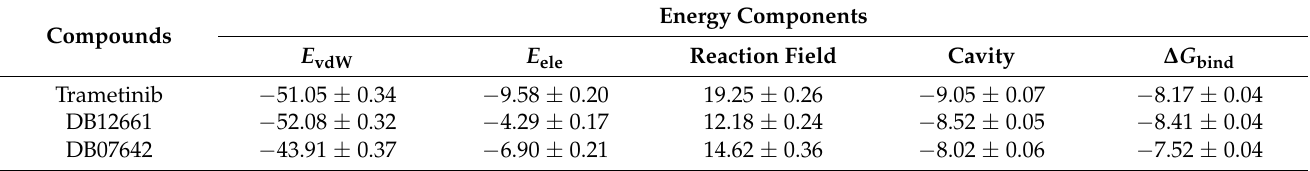
Table 4. Average ∆ G bind values (kcal/mol) of focused compounds as well as trametinib in complex with MEK1 calculated by the SIE method using α = 0.105, γ = 0.013 and C = − 2.89, respectively. Energy Components Compounds E vdW E ele Reaction Field Cavity ∆ G